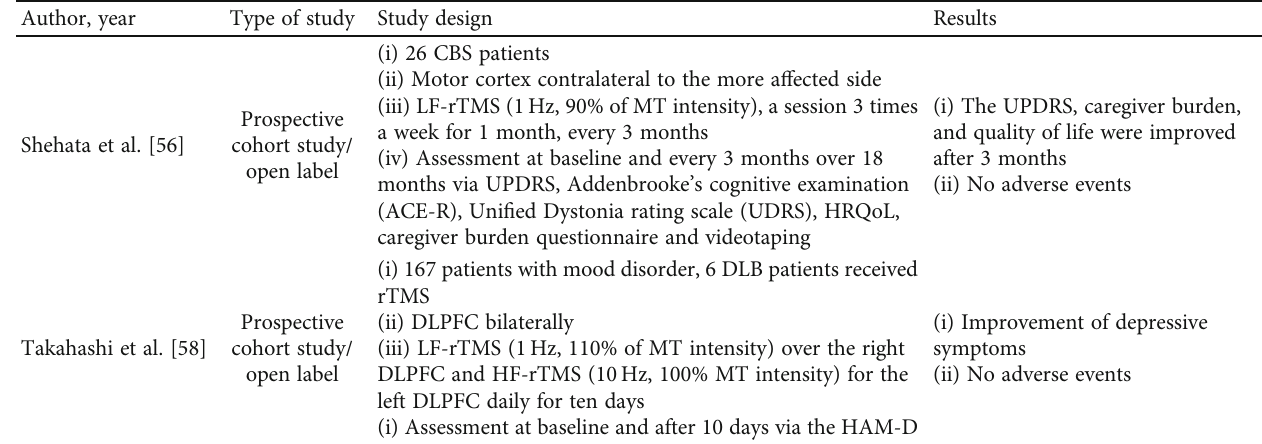
Table 3: Studies assessing rTMS in CBD and